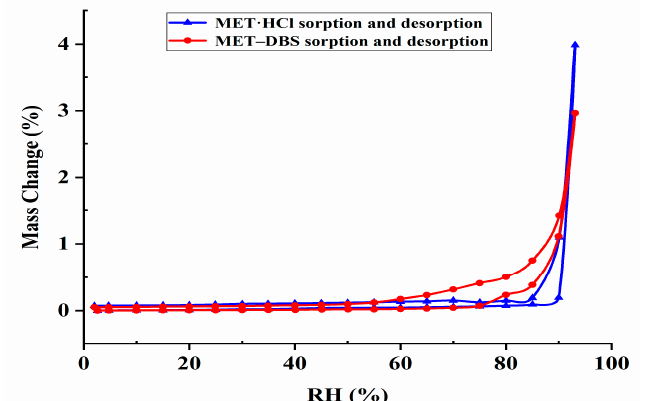
Figure 15. The dynamic vapor adsorption plot for MET · HCl and drug–drug multicomponent crystal of MET–DBS.